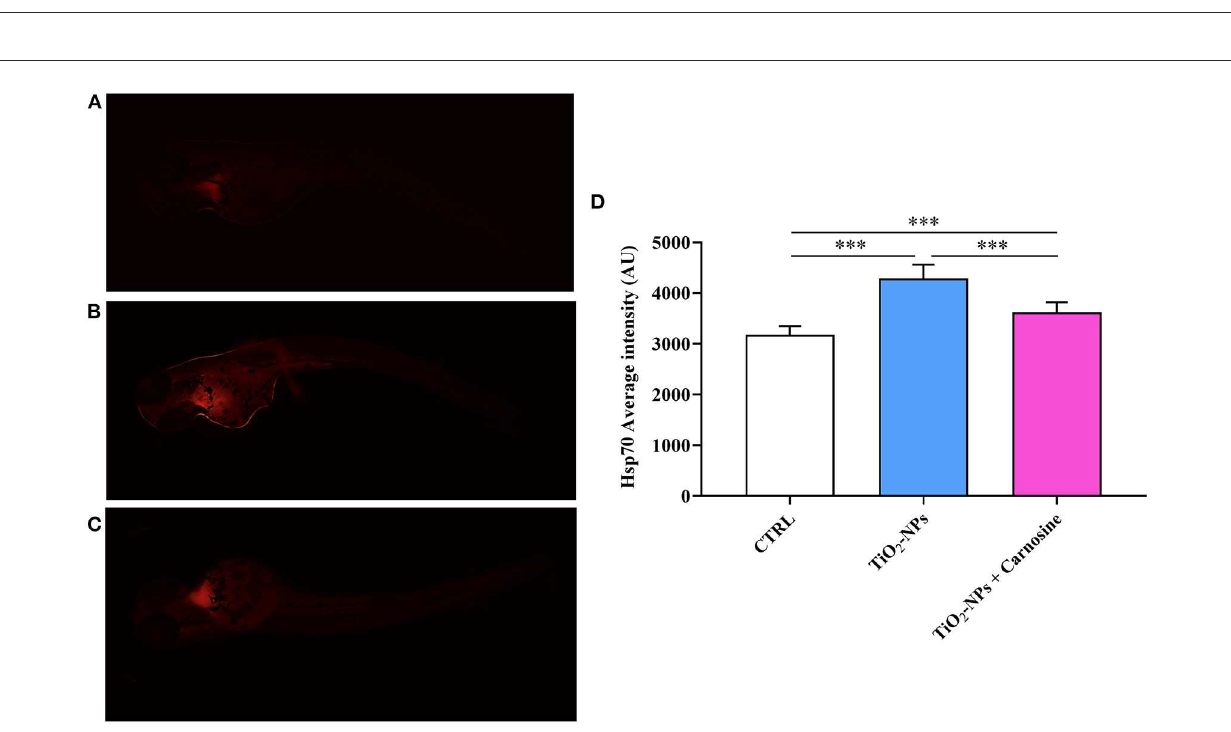
FIGURE6 Hsp70 expression levels in (A) untreated larvae, (B) TiO 2 -NPs-treated larvae, and (C) TiO 2 -NPs-treated larvae in the presence of carnosine 20mM (1h pre-treatment). Carnosine was kept during the exposure to TiO2-NPs. The average fluorescence intensity (AU) of at least 5 values for fixed larva is reported in (D) . SD is represented by vertical bars. ***Significantly different, p <